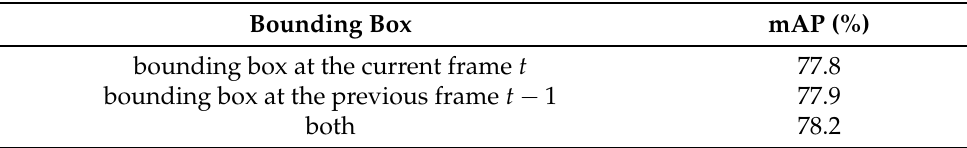
Figure 8. Detection results of “large motion” events from ImageNet VID validation dataset. Our proposed method using the event detection module shows improvements of detecting “large motion” events compared with the still-image baseline Faster R-CNN and our proposed method without using the event detection module. Table 2. Performance comparison with different bounding boxes to generate weak annotations for event detection module.